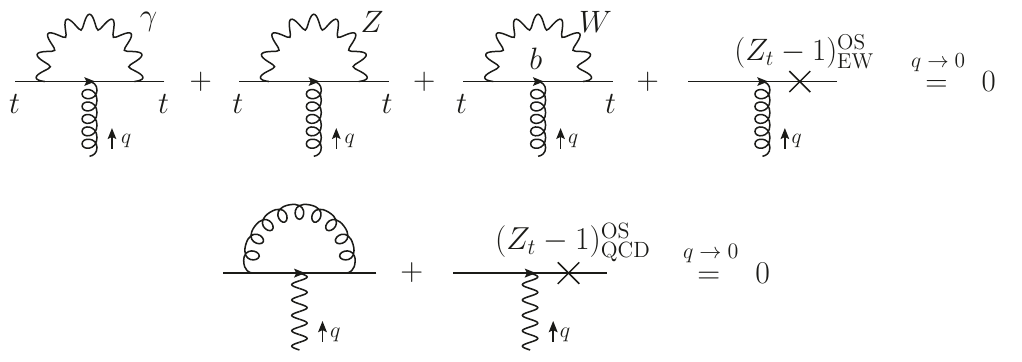
Figure 5 . Cancellation of the electroweak gt (cid:22) t vertex correction and the QCD (cid:13)t (cid:22) t vertex correction in the on-shell scheme. The vector current itself is conserved and therefore not renormalized.